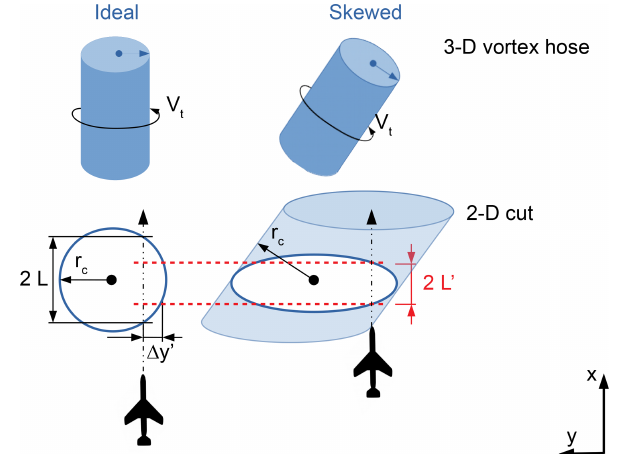
Figure 16. Sketch of an ideal and skewed (exaggerated) vortex hose at hub height. The simplifications in the evaluation method only consider components in the x − y plane, which leads to an under- prediction of the real peak-to-peak distance. The fact that the real “ r c ” does not lie in the x − y plane leads to an error. A horizontal cut through the vortex has an ellipsoidal geometry instead of a circular one, as in ideal measurement